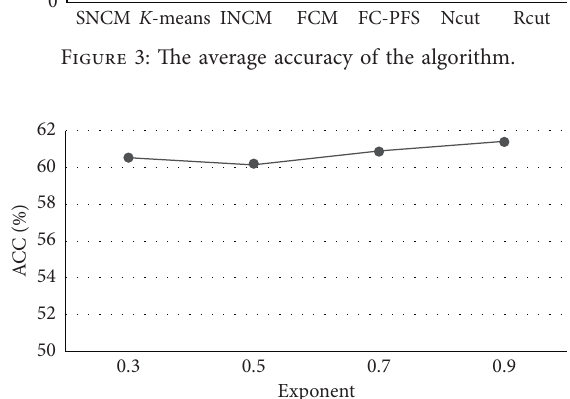
Figure 4: The average accuracy of the algorithm under different